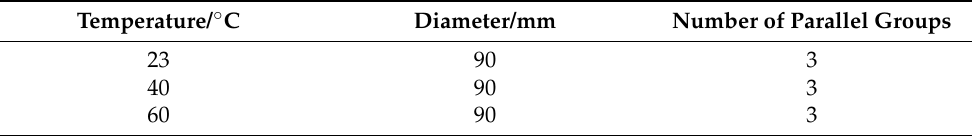
Table 4. The experimental configuration.